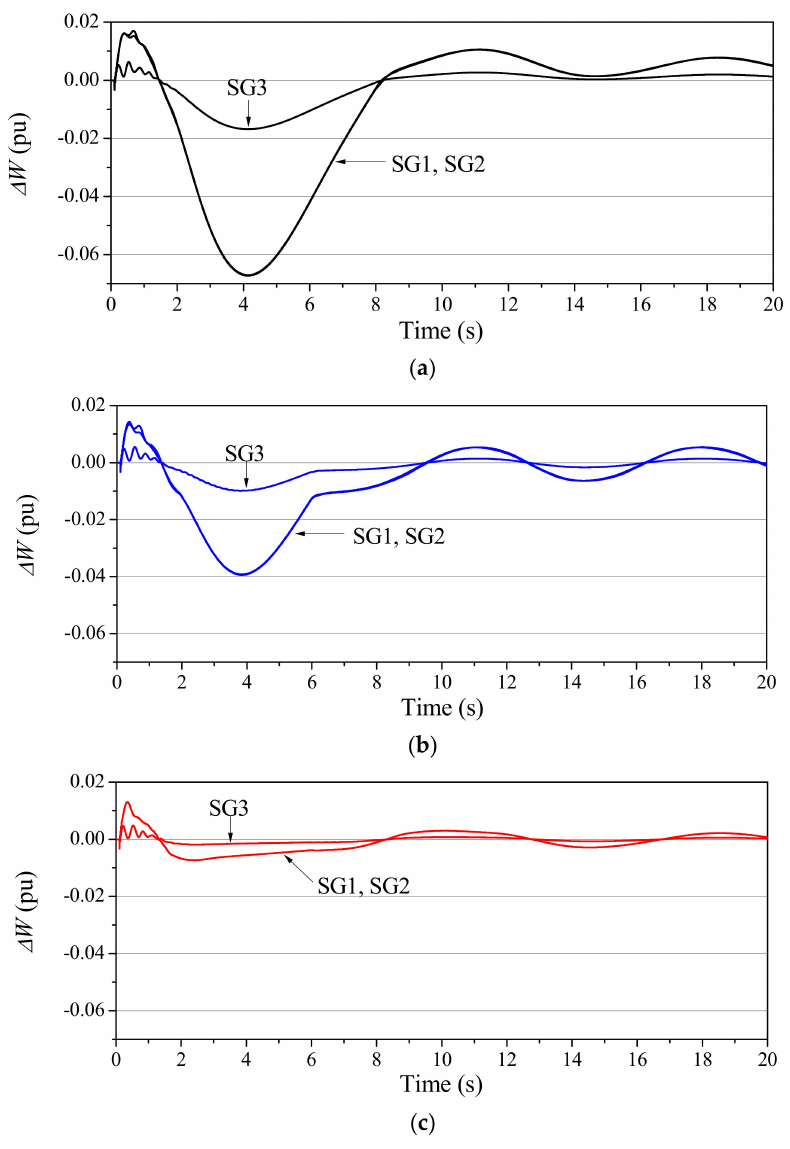
Figure 8. ∆ W : deviation of kinetic energy of each SG: ( a ) No control; ( b ) Case 1; ( c ) Case